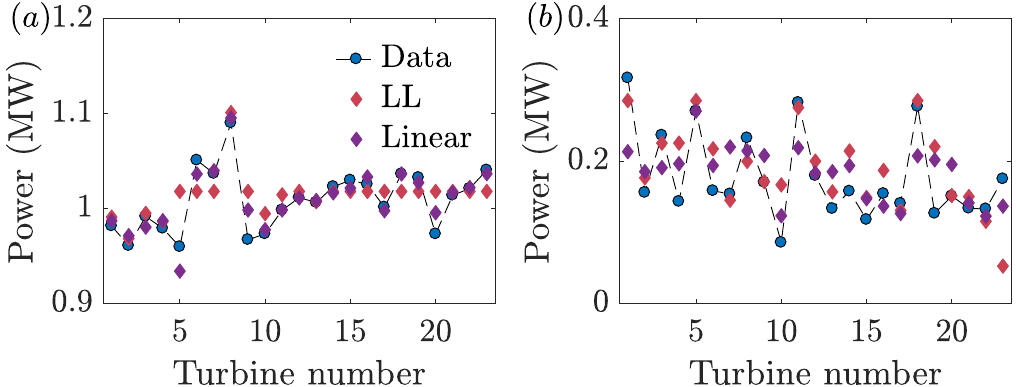
Figure 6. Average power production as a function of turbine number for the lifting line model and linear weight matrix method in Equation (7) for inflow from ( a ) 250 ◦ ± 5 ◦ training data for all wind speeds and ( b ) 330 ◦ ± 5 ◦ development data for u ∞ = 6–7 m/s. Turbines are numbered